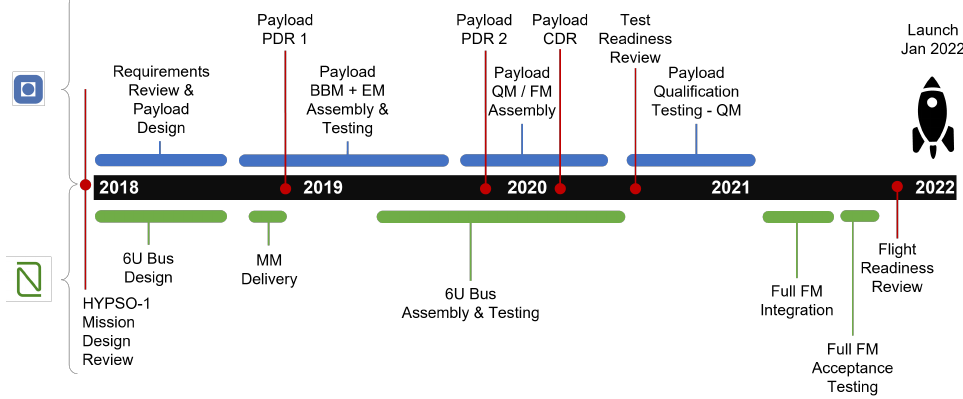
Figure 5. The overall schedule of AIT activities for HYPSO-1. NTNU development is shown in blue and NanoAvionics in green. The red dots represents milestones for the